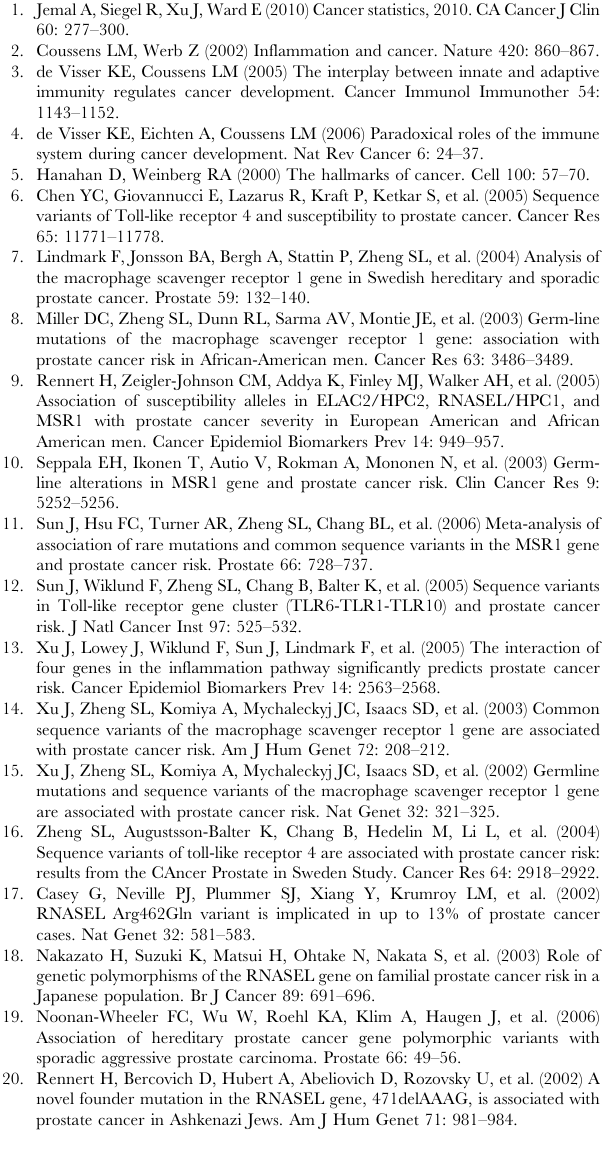
allele frequency; P Hardy-Weinberg : Hardy-Weinberg proportion adequacy test (chi-square test). Table S2 Association of all SNPs analyzed with advanced prostate cancer risk. The next 3 Excel sheets contain the results of the analyses for the whole sample (Overall) and stratified by ethnicities: African Americans and Caucasians. OR: Odds Ratio; 95% CI: 95% confidence interval; P-value: P-value of the Wald test of association of the heterozygote or rare homozygote genotypes compared to the common homozygote genotype or P- value of the allelic trend